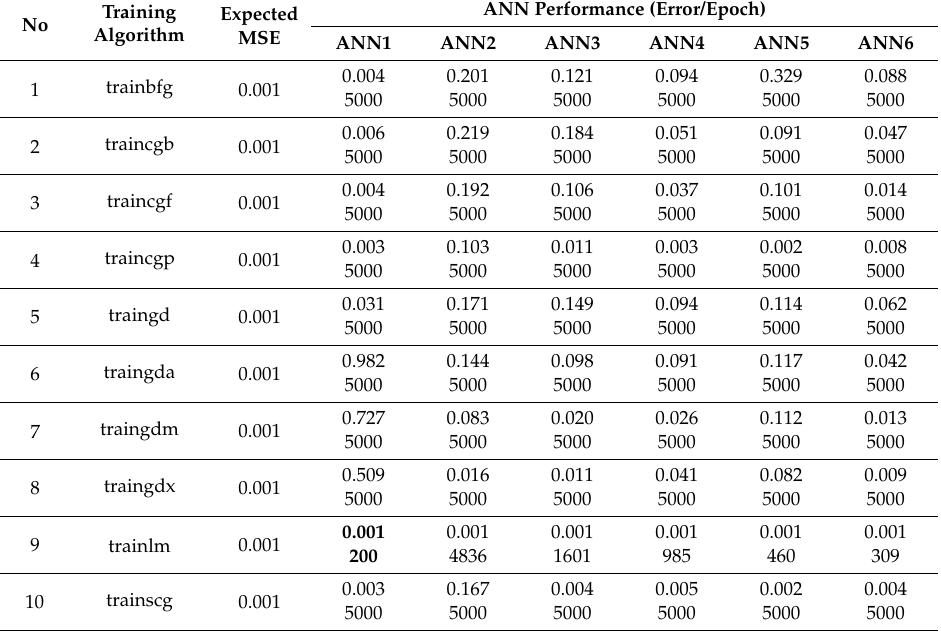
Table 2. Training algorithm performance for each individual ANN model.